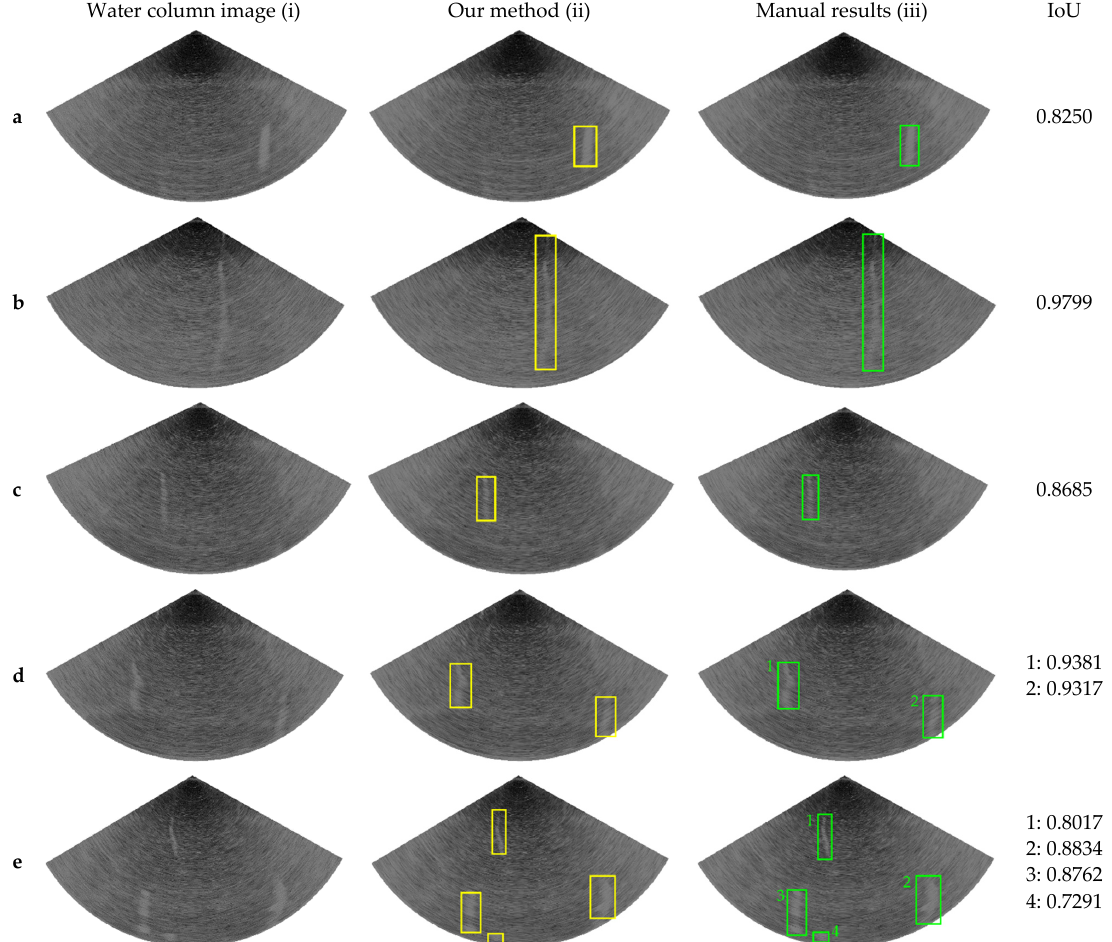
Figure 15. Comparison of our predicted and ground-truth detection results. ( a – e ) are five water column images which contain bubble plume targets. The yellow and green detection boxes show predicted and ground-truth results.